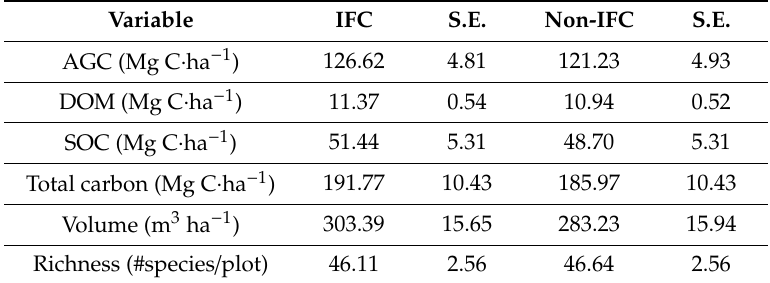
Table A5. Mean values and standard error of AGC, DOM, SOC, total carbon, timber volume and species richness for landscapes with IFC and